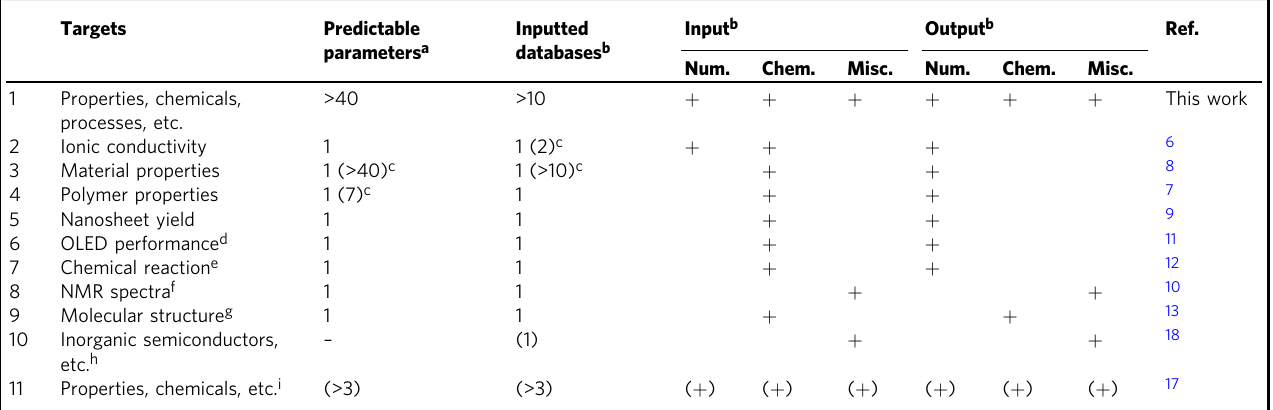
table databases. To integrate knowledge, varied information must be inputted and outputted (i.e., multimodal learning) 19,20 .